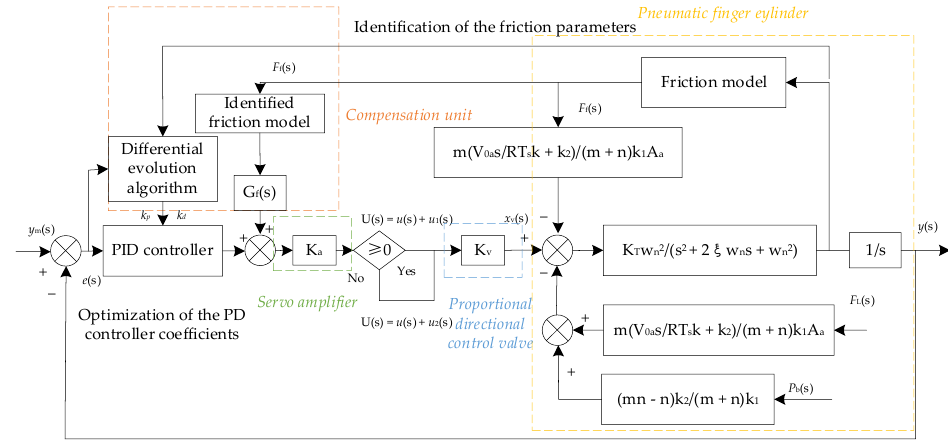
Figure 6. Control structure chart of friction identification compensation [52].